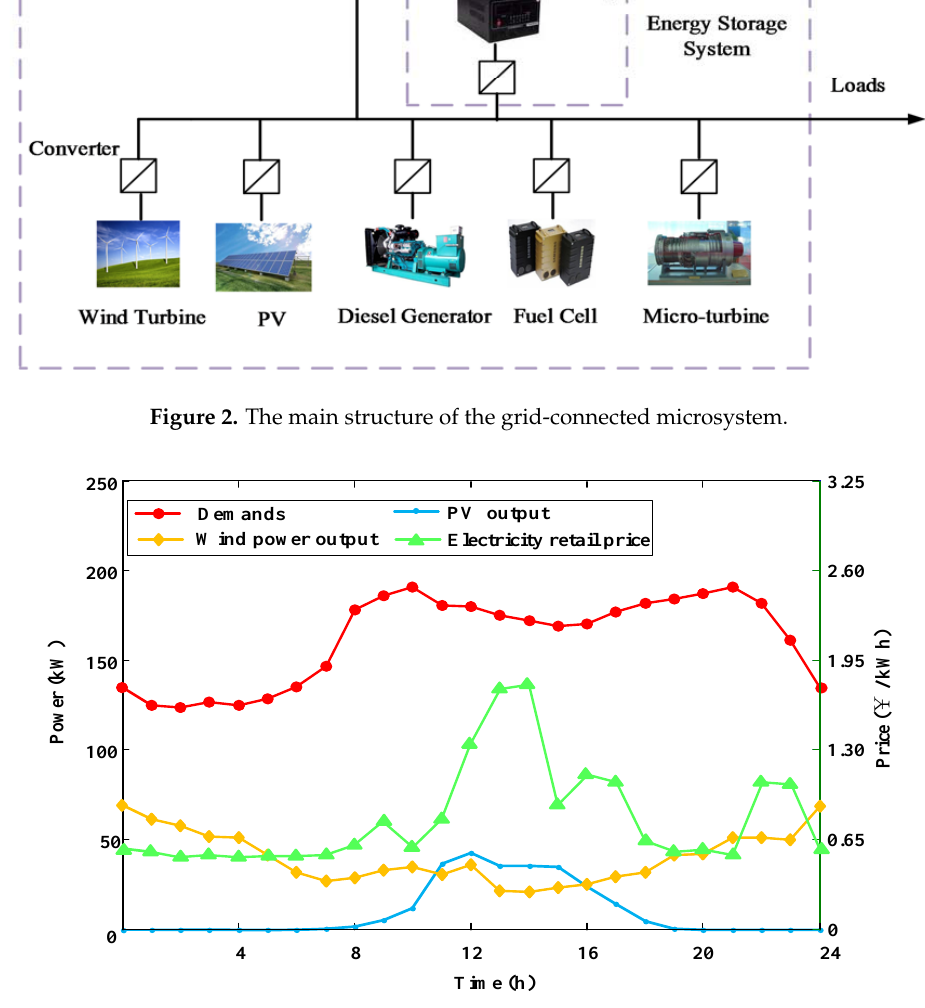
Figure 3. The predicted outputs of the PV panels, wind turbines and local demands. Table 1. The rated parameters of local generators of the grid-connected microgrid.